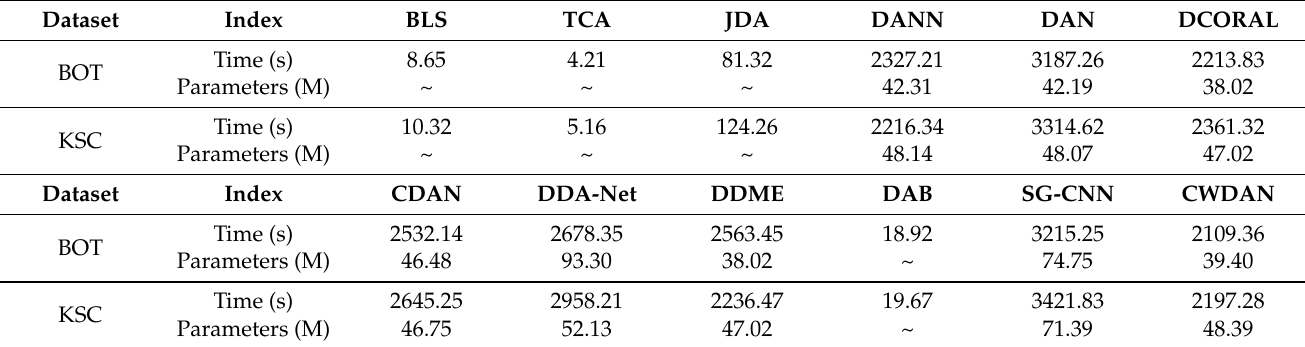
Table 9. Running time and number of parameters for all the